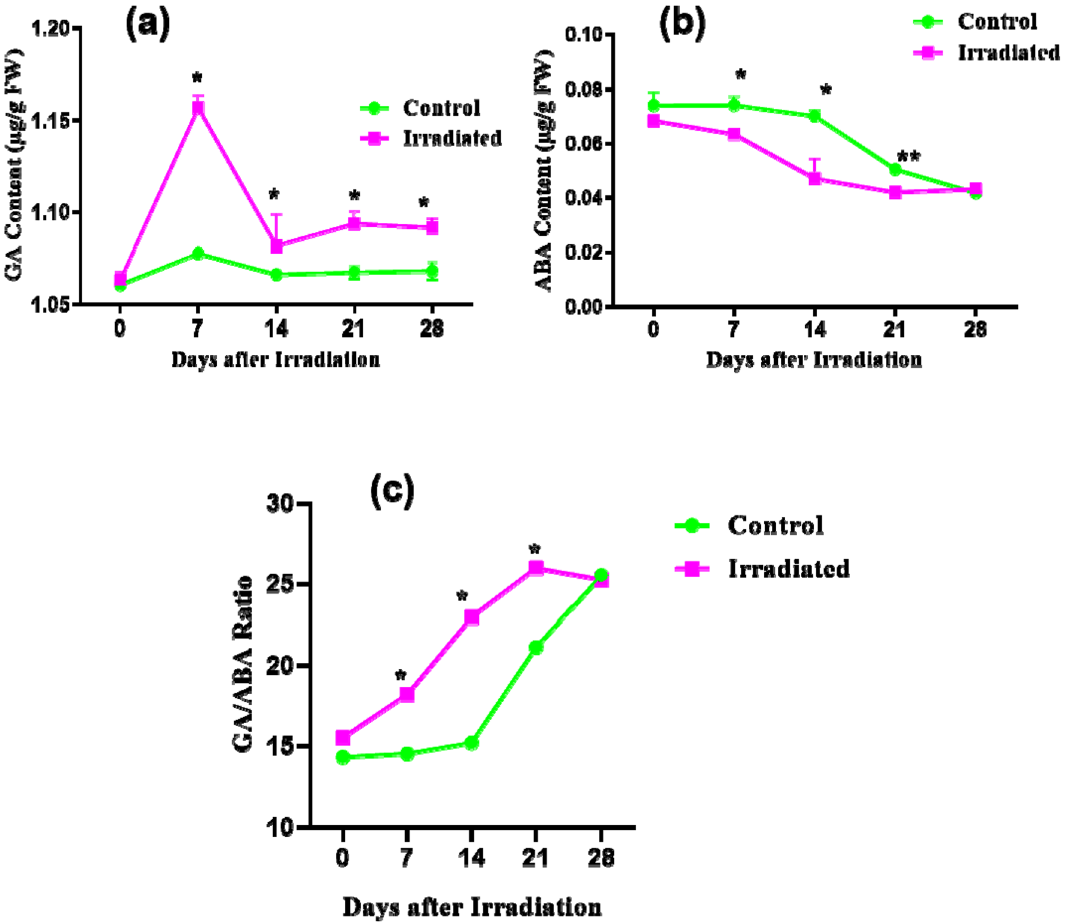
Figure 1. Quantification of phytohormones from control and laser-irradiated seeds and seedlings ( a ) gibberellic acid, ( b ) abscisic acid and ( c ) GA/ABA ratio from seeds and seedlings of brinjal ( Solanum melongena L.) var. Mattu Gulla in response to He–Ne laser irradiation and un-irradiated control during different developmental stages (0–28 DAI). Data are expressed as mean ± SD and significant at **p < 0.01 and *p < 0.05 compared with non-irradiated control (n =